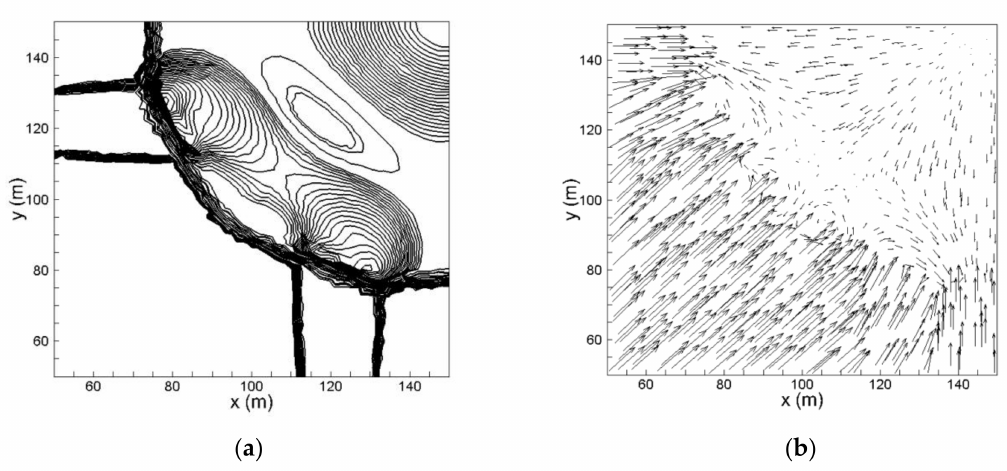
Figure 24. Numerical results of the 2D Riemann problem at t = 4 s: ( a ) contours of water surface elevation; ( b ) vector field of flow